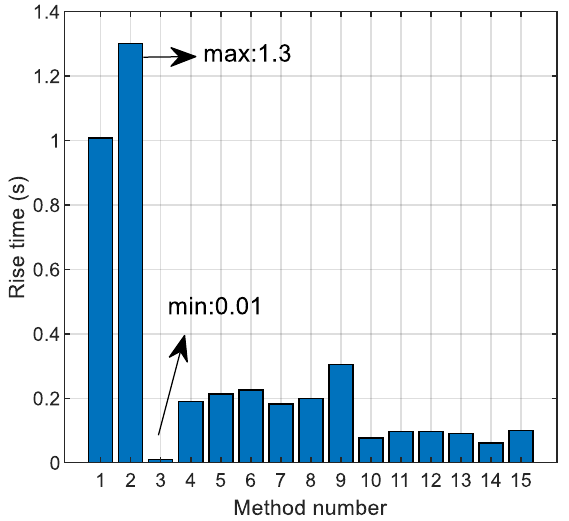
Figure 6. Rise time for each method from Table 3.